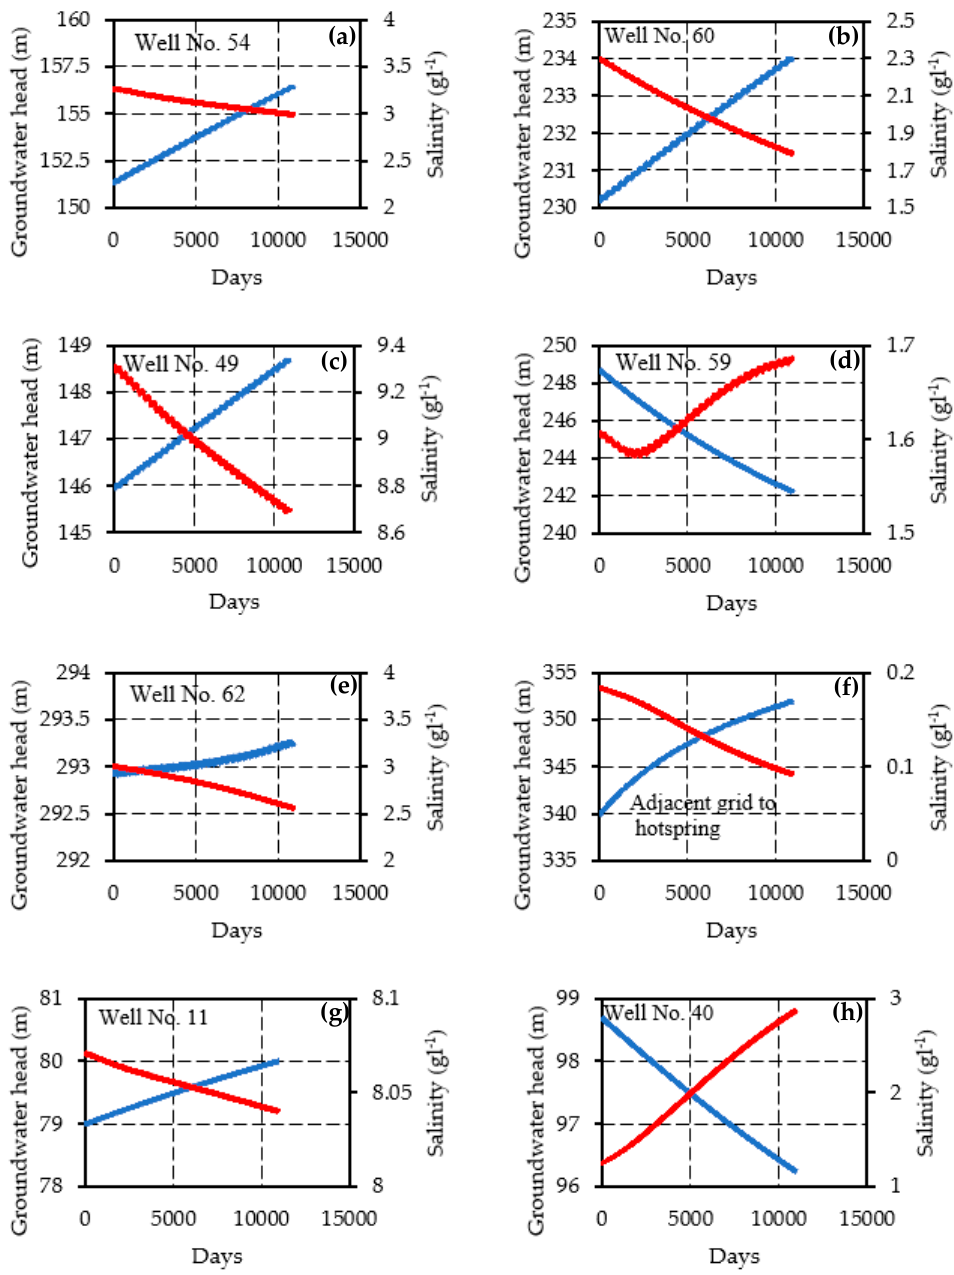
Figure 9. Predicted change in groundwater head and concentration of salinity from the year 2021 to 2050 using the current rate of groundwater pumping and irrigation return flow in correspondence of: ( a ) Well No. 54; ( b ) Well No. 60; ( c ) Well No. 49; ( d ) Well No. 59; ( e ) Well No. 62; ( f ) Adjacent grid to hotspring; ( g ) Wll No. 11; ( h )Well No. 40.